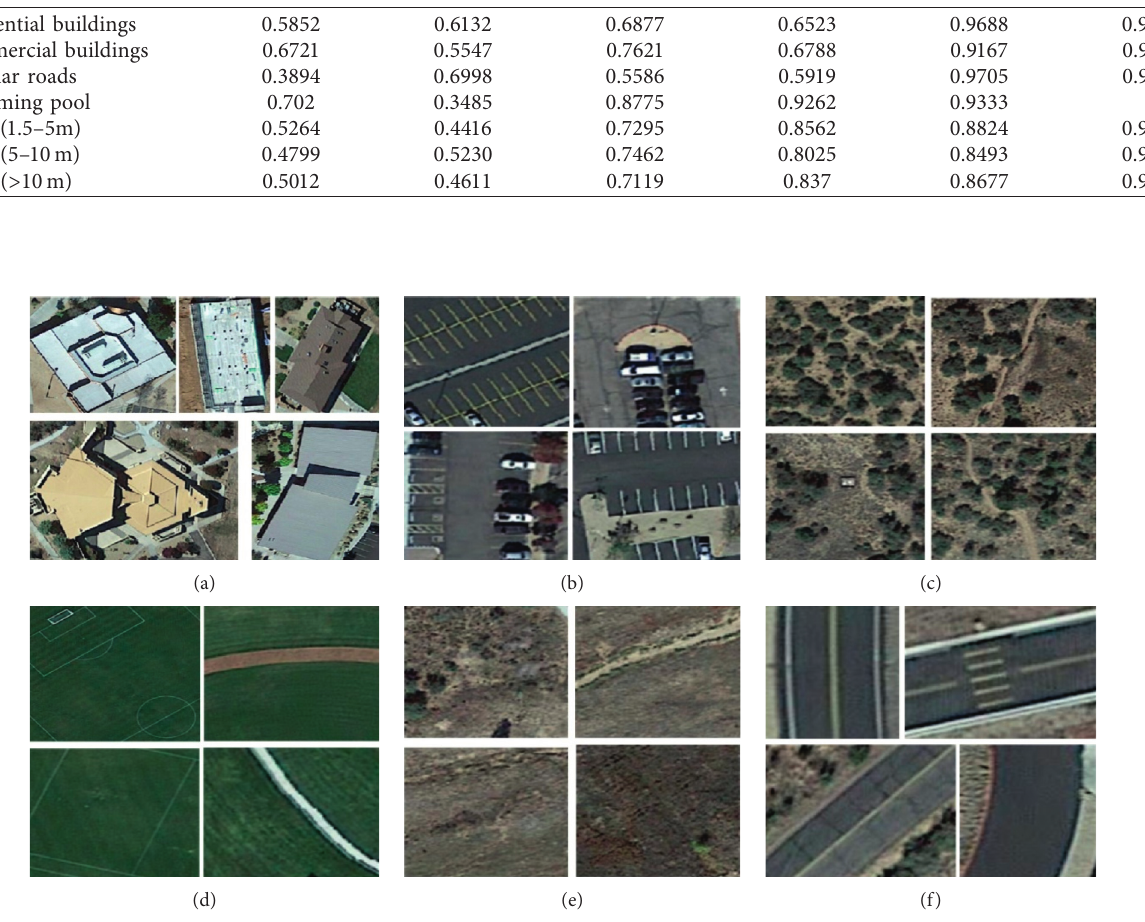
Figure 6: Illustration on the object to be recognized from the second experimental datasets. (a) Buildings. (b) Parking lot. (c) Shrub. (d) Grass. (e) Bare soil. (f)